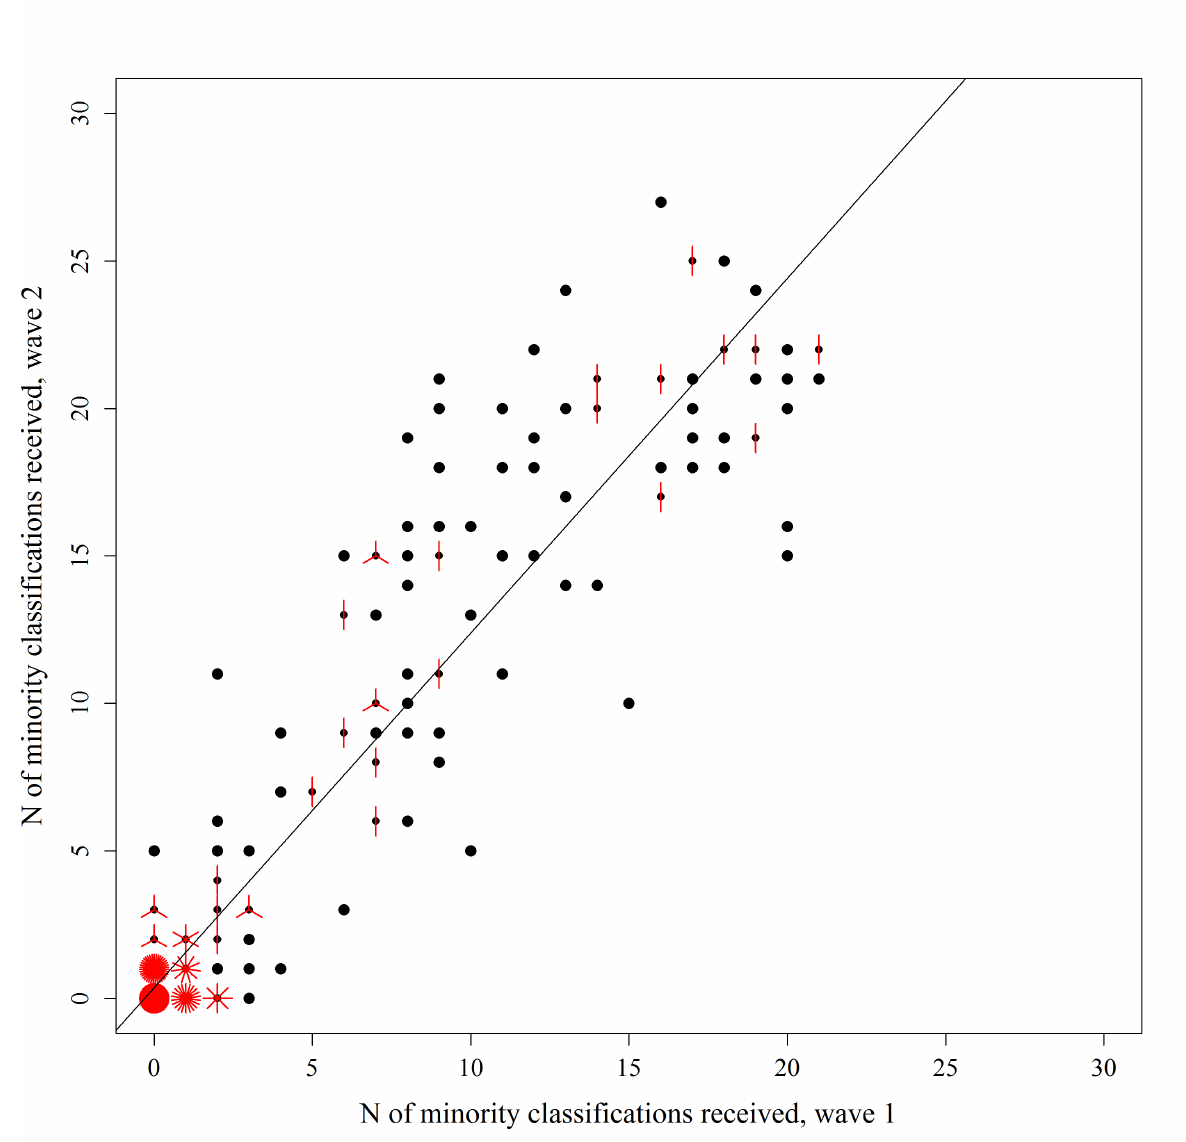
Figure 2: Number of students’ incoming minority classifications in wave 1 and wave 2. points of time ( N of students in classrooms is between 20 and 30). Furthermore, the sunflower plot in Figure 2 demonstrates that minority classification in-degrees are also related to each other over time: those nominated more at the first observation (axis X) are also nominated more at the second observation (axis Y). “Leaves of the sunflower” (lines around the circles) indicate how many times each point appears in our sample. We can see that a big proportion of students appear at and